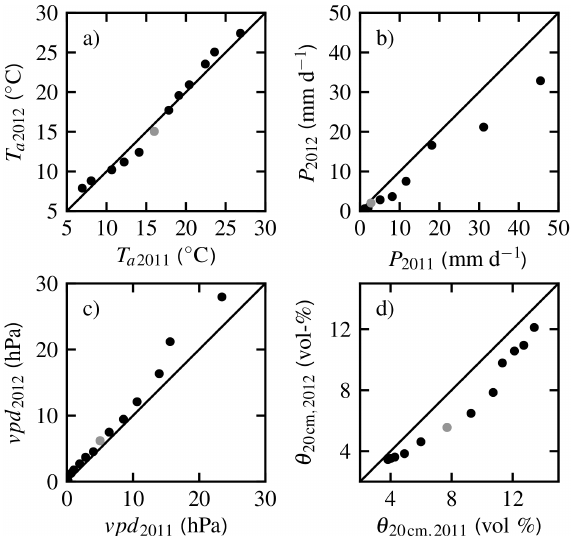
Figure 3. Quantile–quantile plot of important climate and environ- mental parameters for the years 2011 and 2012 based on daily aver- ages. Black dots represent the 0.01, 0.05, 0.1, 0.2, 0.3, 0.4, 0.6, 0.7, 0.8, 0.9, 0.95, and 0.99 quantiles of the respective distribution. Grey dots represent the 0.5 quantile. (a) Air temperature T a , (b) precipita- tion P , and (c) vapour pressure deficit of the air vpd, each measured at 20m height above the ground. (d) Soil moisture in the first 20cm θ 20cm (root zone of understorey vegetation).